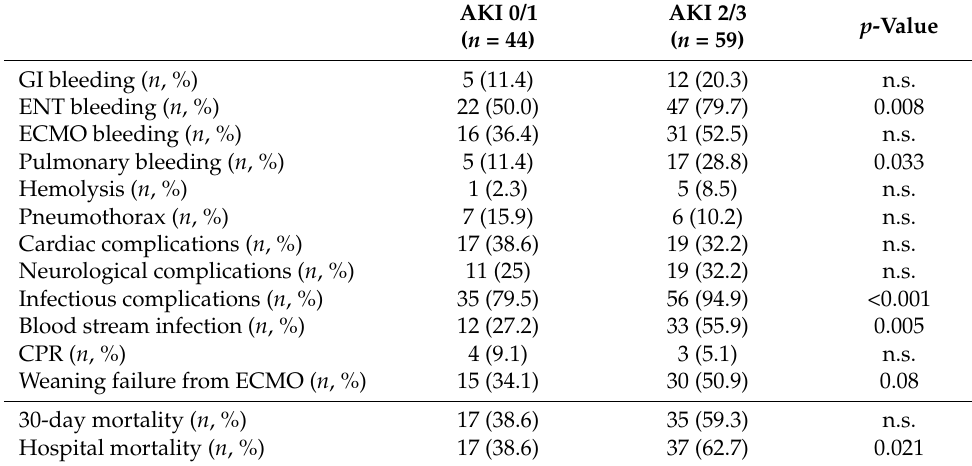
Table 2. The outcomes of patients, comparing AKI 2/3 and AKI 0/1 groups.